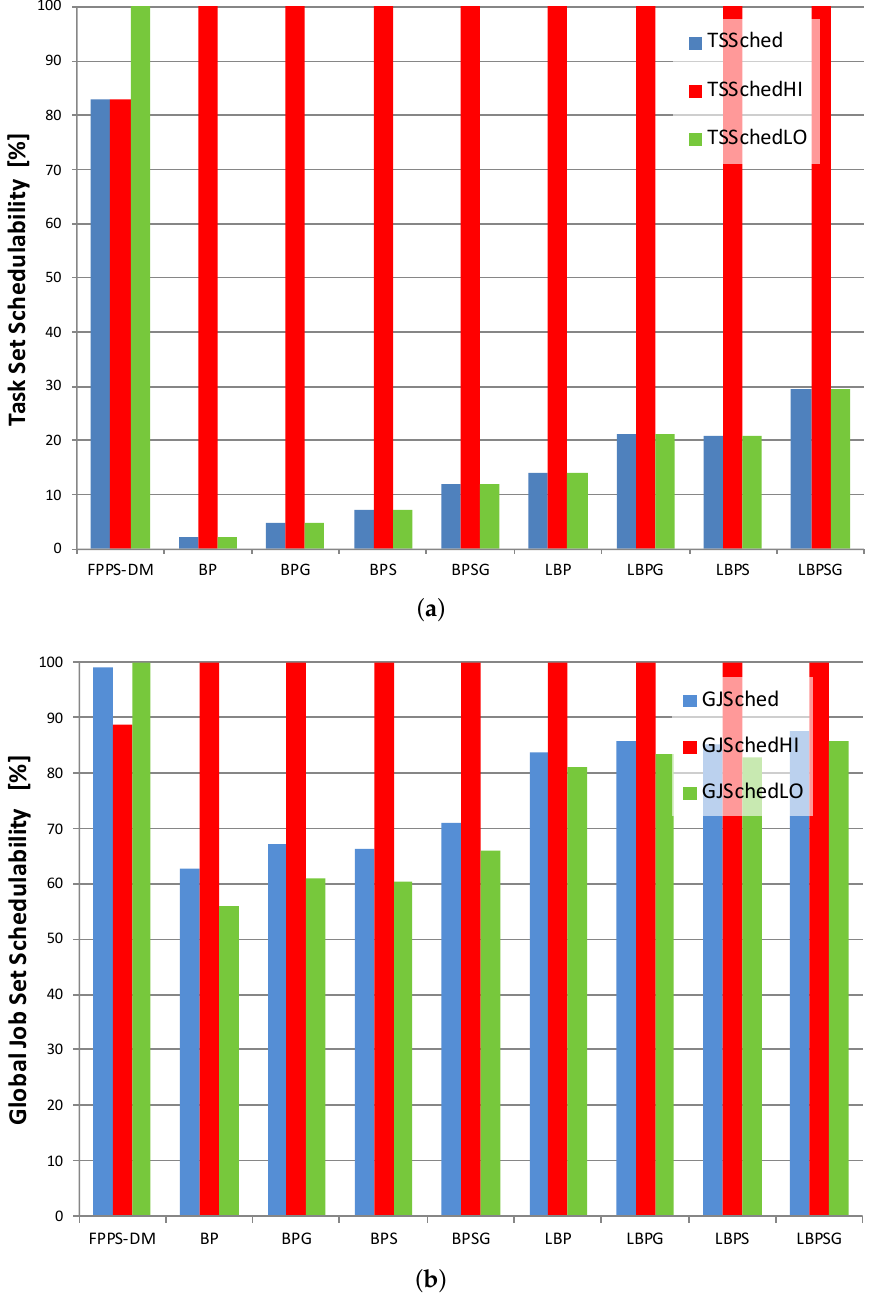
Figure 7. BP and LBP variants: schedulability in HC-LP scenario: ( a ) task sets with no jobs missed; and ( b ) average of jobs scheduled per task